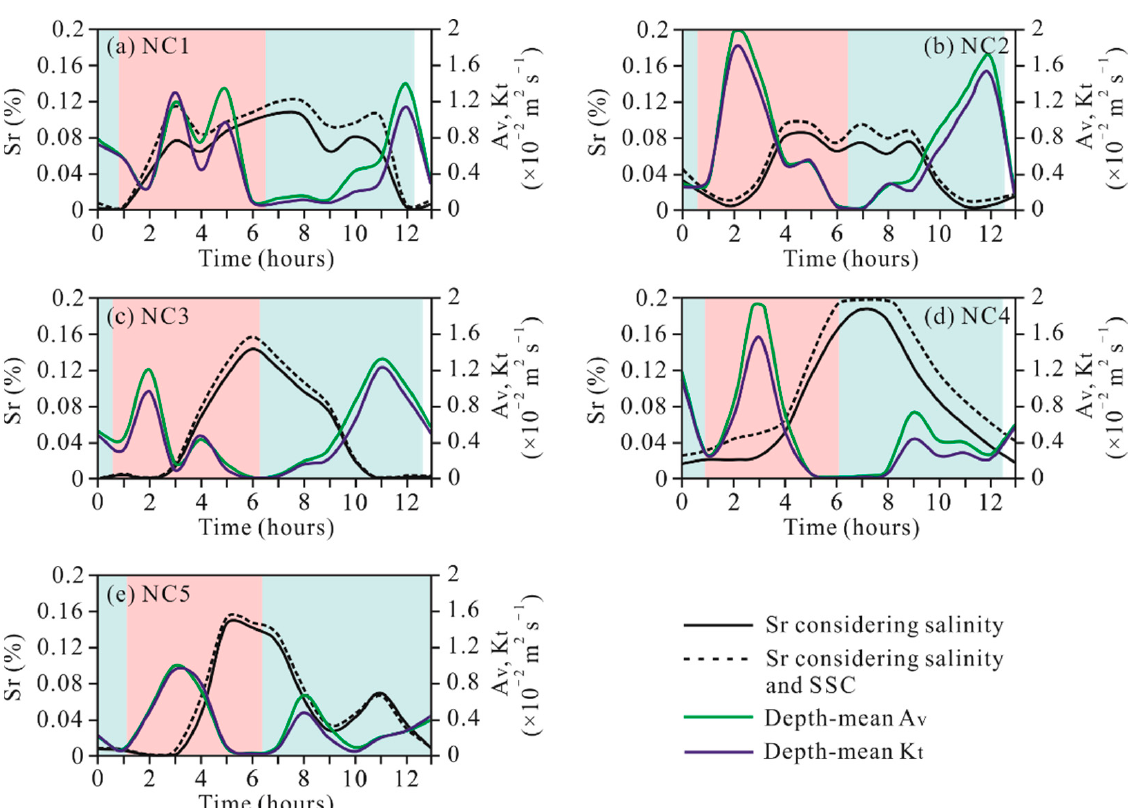
Figure 4. Vertical profiles of tidally averaged velocities (m s − 1 ) over flood tide and ebb tide at NC1 to NC5 stations ( a – e ). Here, σ is relative depth, σ = − z / h ( σ = 0 is the surface and σ = 1 the bottom).